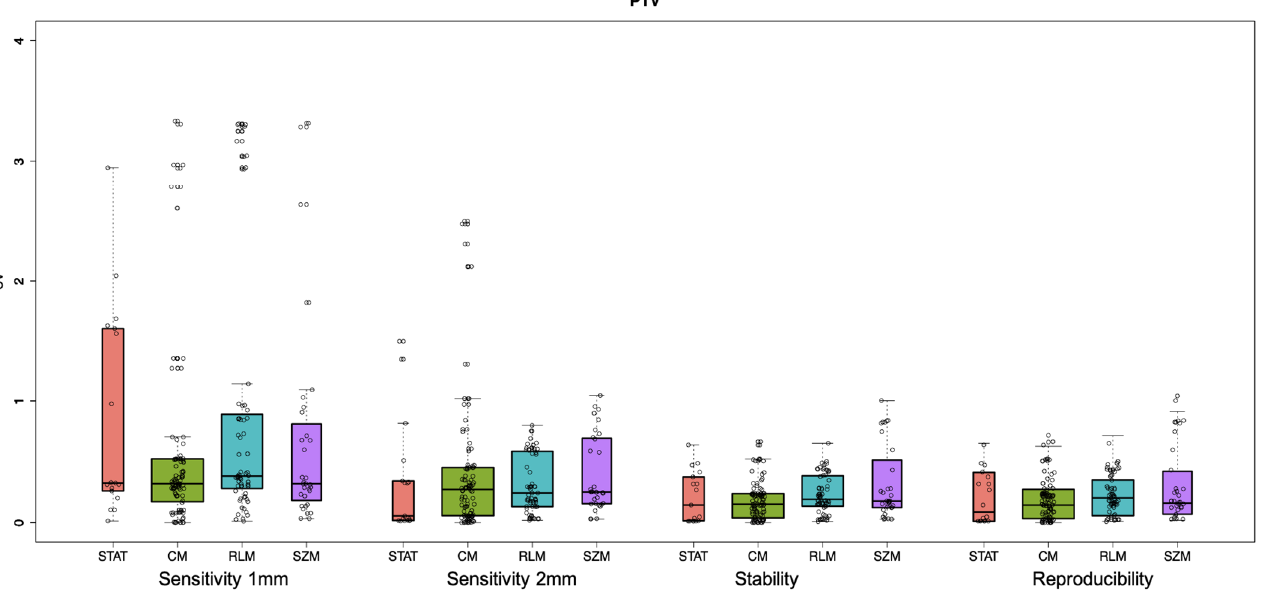
Figure 6. Venn diagrams showing the dosiomic features that are both stable and sensitive between the stability and sensi- tivity study for the PTV and left parotid. The sensitivity CV threshold was set to two different values: CV TH > 1 and CV TH > 0.8 for the PTV.